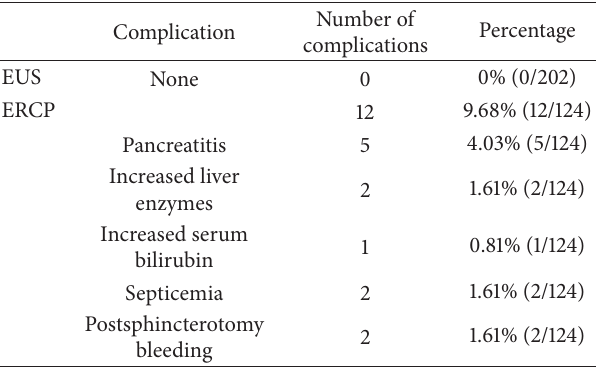
Table 2: The complications of linear EUS and